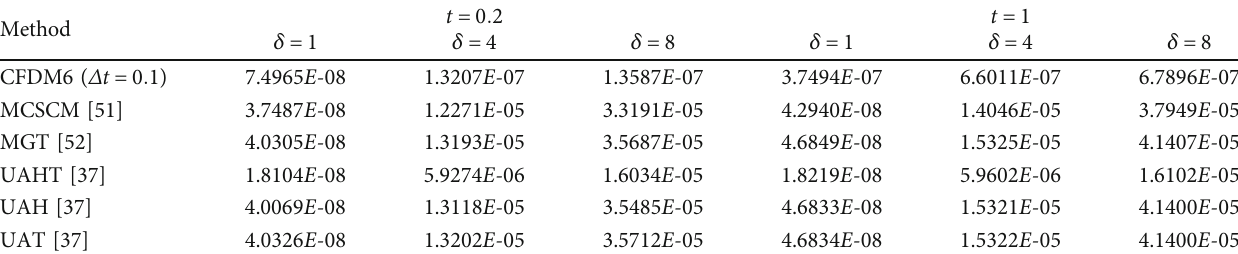
β = 1 , γ = 1 , η = 0 : 001 , h = 0 : 1 , and Δ t = 0 : 001 Table 5: Comparison of L ∞ error norm of Example 4 with